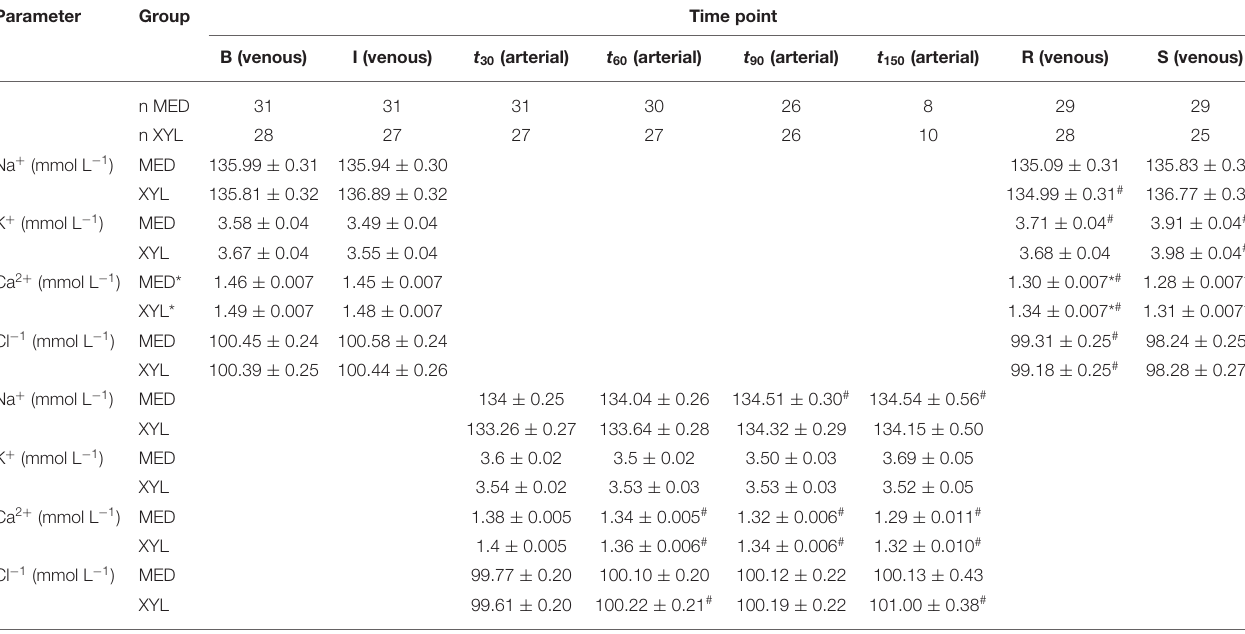
TABLE 3 | Mean ± SEM of electrolytes in horses with medetomidine isoflurane (group MED) or xylazine isoflurane (group XYL) balanced anesthesia. Parameter Group Time point